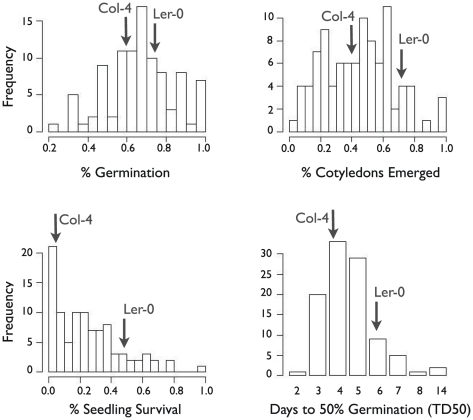
Phenotypic frequencies for the Col × Ler RILs.Phenotypic means for parental lines are indicated by arrows.